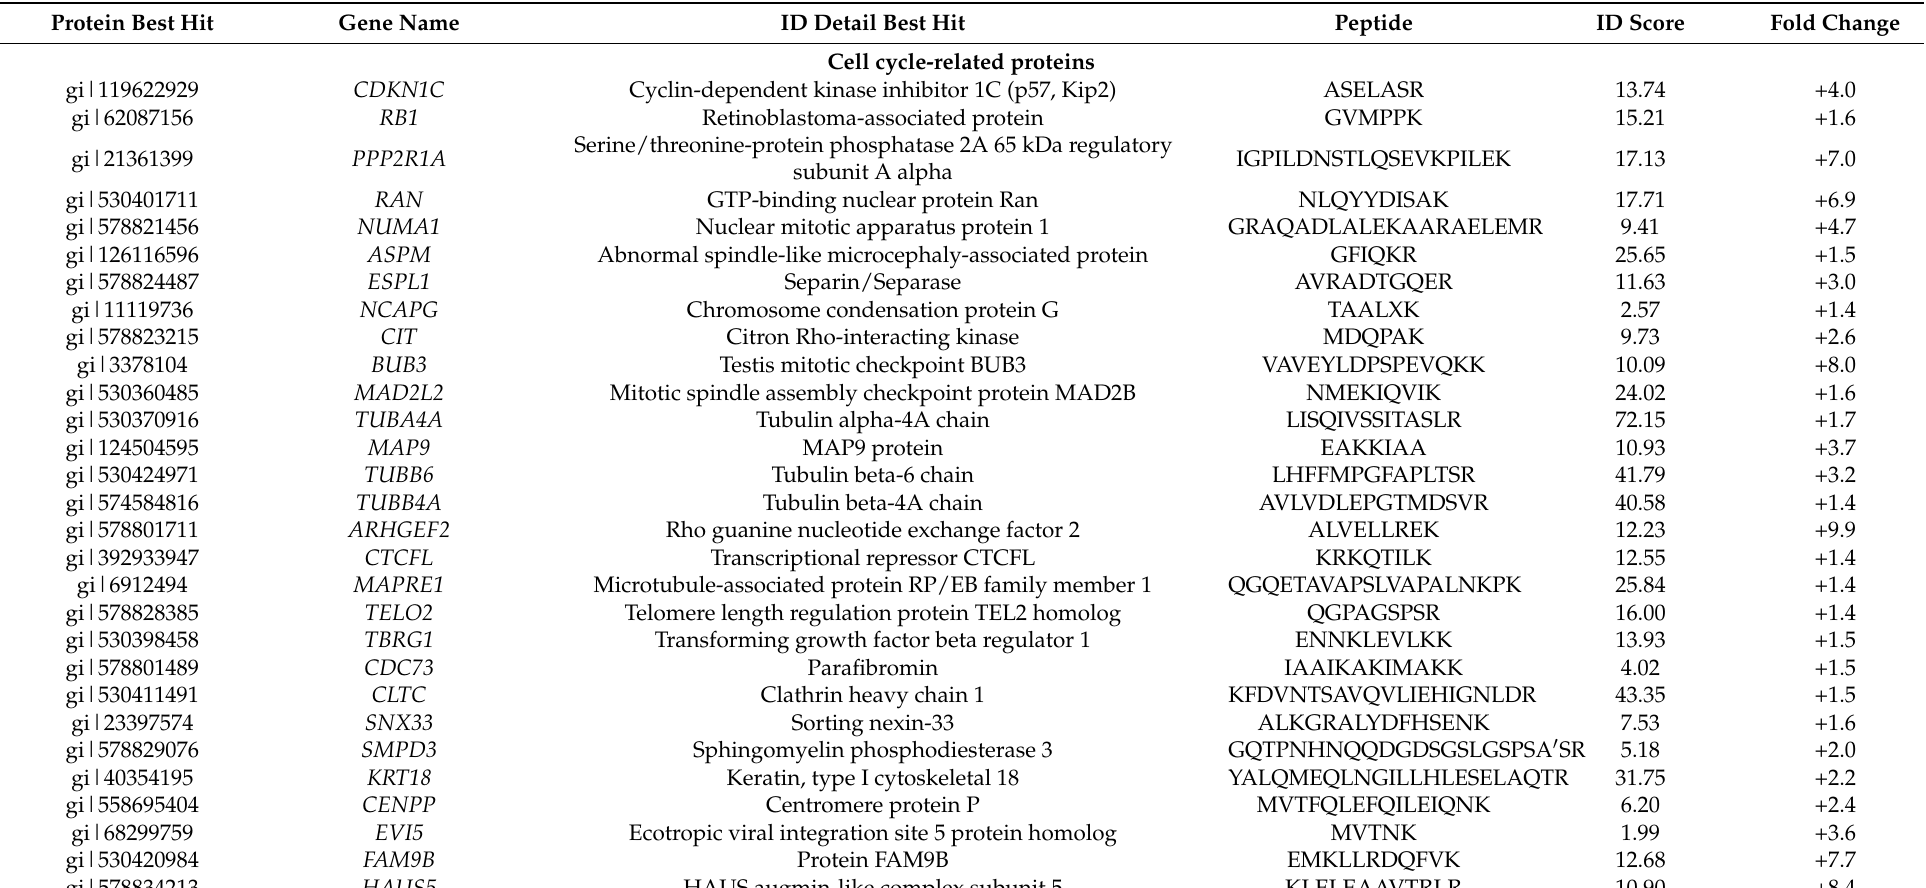
Table 2. Cell cycle-, apoptosis- and cell signaling-related proteins significantly expressed in 6 µ M 7- α -hydroxyfrullanolide-treated cells at 24 h. Fold changes in the expression of differentially expressed proteins compared with the expression in the control. +; upregulated expression, *; the cell signaling proteins were associated with both cell cycle and apoptosis pathways. More cellular signaling proteins were available in Supplementary Materials Spreadsheet